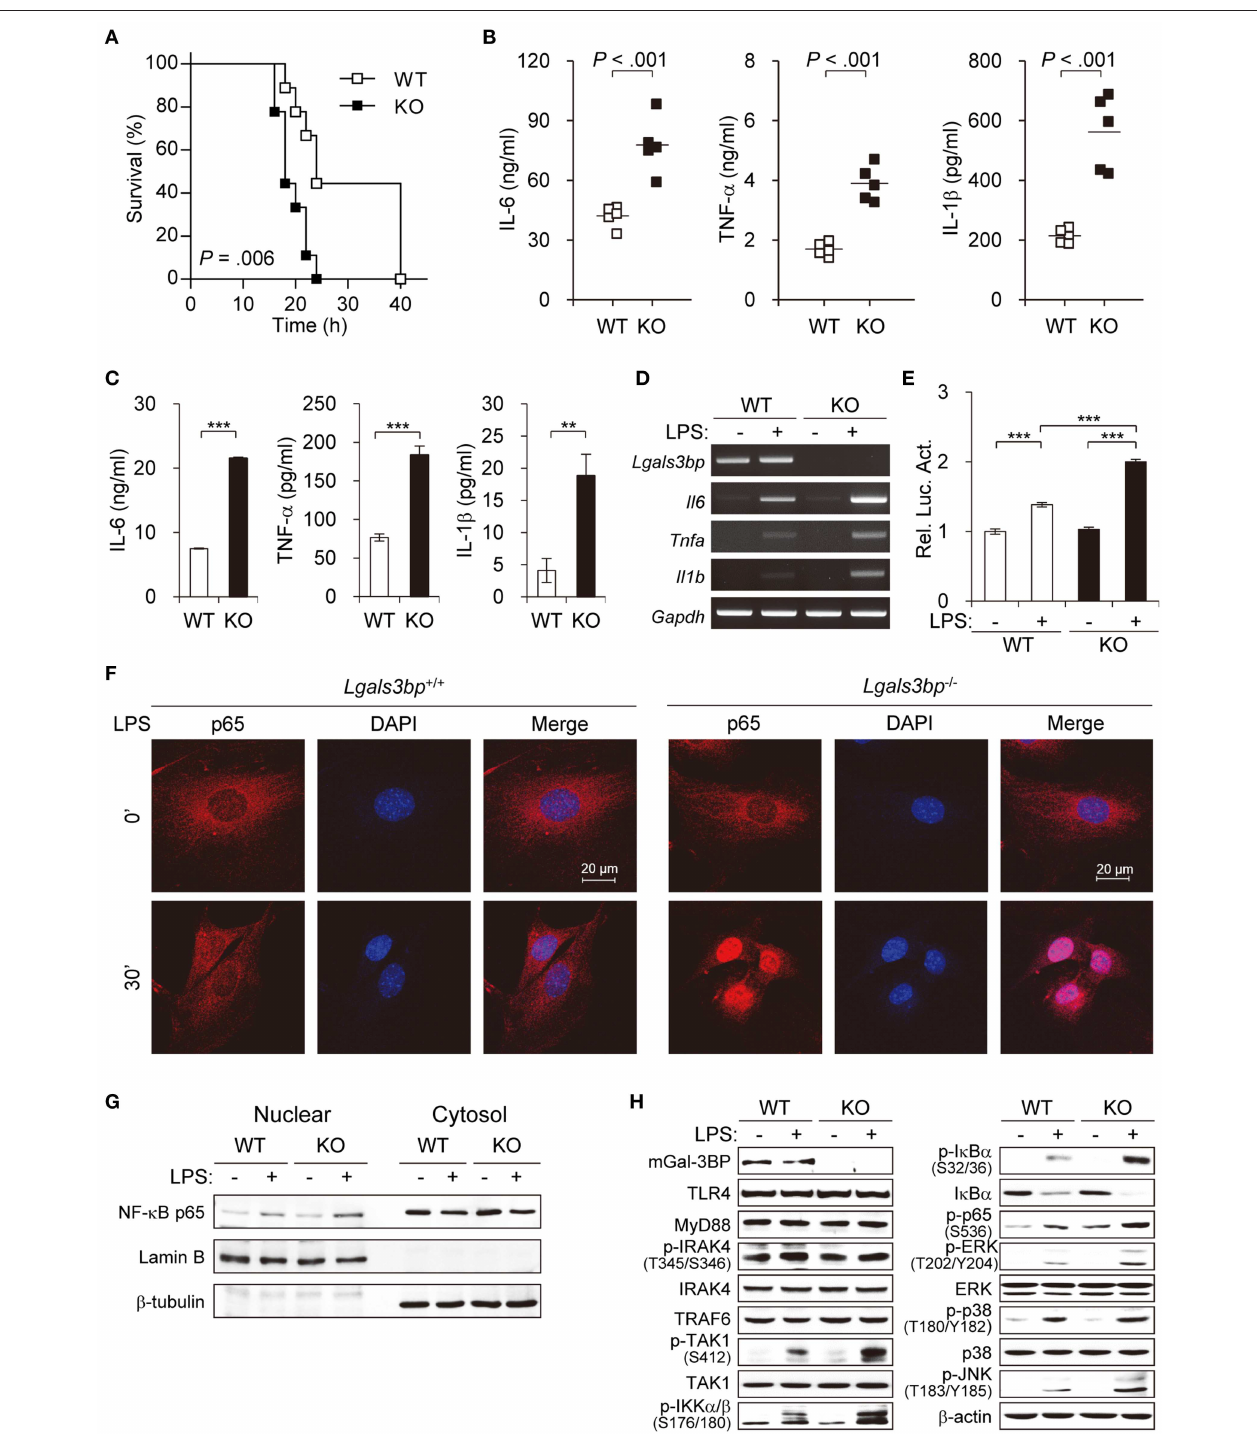
FIGURE 1 | Lgals3bp deficiency promotes TAK1-dependent NF- κ B activation and proinflammatory cytokine production. (A) LPS and D -galactosamine were injected intraperitoneally into WT and KO mice ( n = 9 per group), and their survival was monitored for 40h. (B) WT and KO mice ( n = 5 per group) were challenged with LPS. Levels of IL-6 at 3h, TNF- α at 1h, and IL-1 β at 3h were measured by ELISA. Vertical lines indicate the mean of five experiments. (C) MEFs from WT and KO mice were cultured and stimulated with LPS for 24h. IL-6, TNF- α , and IL-1 β levels in culture supernatants were measured by ELISA. (D) The mRNA expression levels of Il6 , Tnfa , and Il1b in MEFs stimulated with LPS for 24h were measured by RT-PCR. Gapdh was used as a loading control. (E) MEFs were transfected with